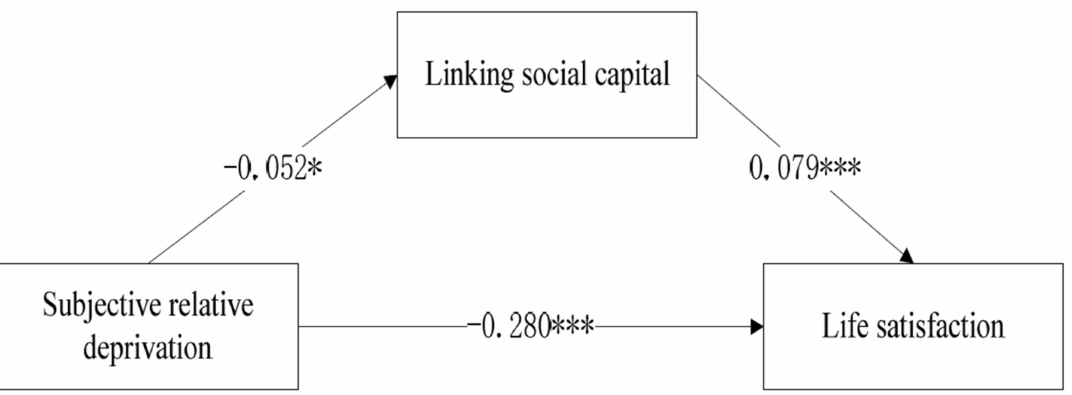
Figure 3. A path model of how subjective relative deprivation influences life satisfaction. * p ≤ 0.05; *** p ≤ 0.001. Table 4. The e ff ects of subjective relative deprivation on life satisfaction through linking social capital with friendship network size as a